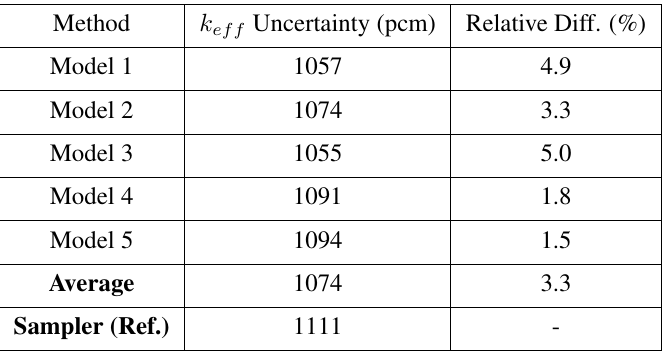
Table 4: Comparison of k uncertainty as calculated by the five DNN models to the eff uncertainty calculated by SCALE/Sampler (last